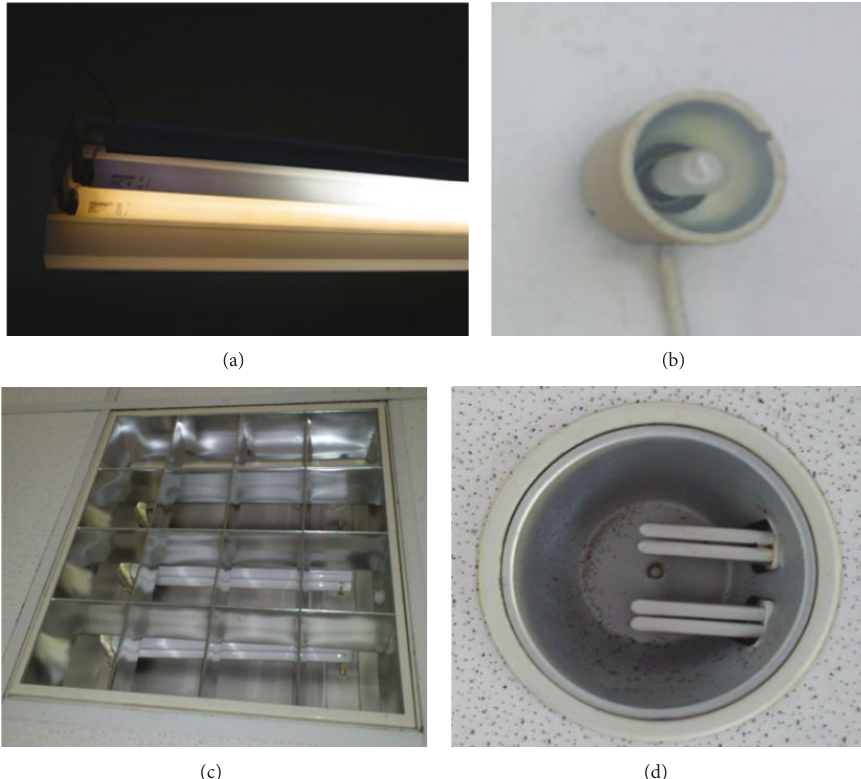
Figure 3: (a) Philips fluorescent tube 36 W 4 feet, (b) Philips compact fluorescent light (CFL) bulb 14W fitting E27, (c) Philips 36 W/4Pin fitting 2G11, and (d) Philips PL-C 13W 2Pin fitting